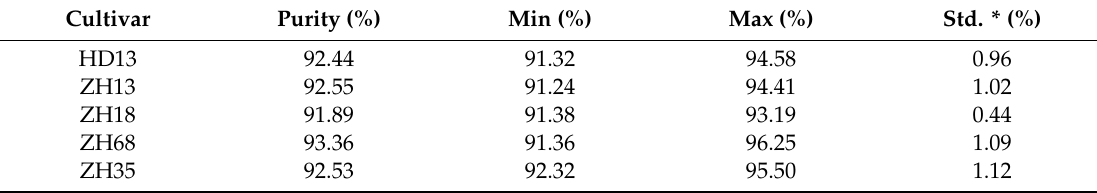
Table 3. The purity of five soybean cultivars based on SLAF-seq. Cultivar